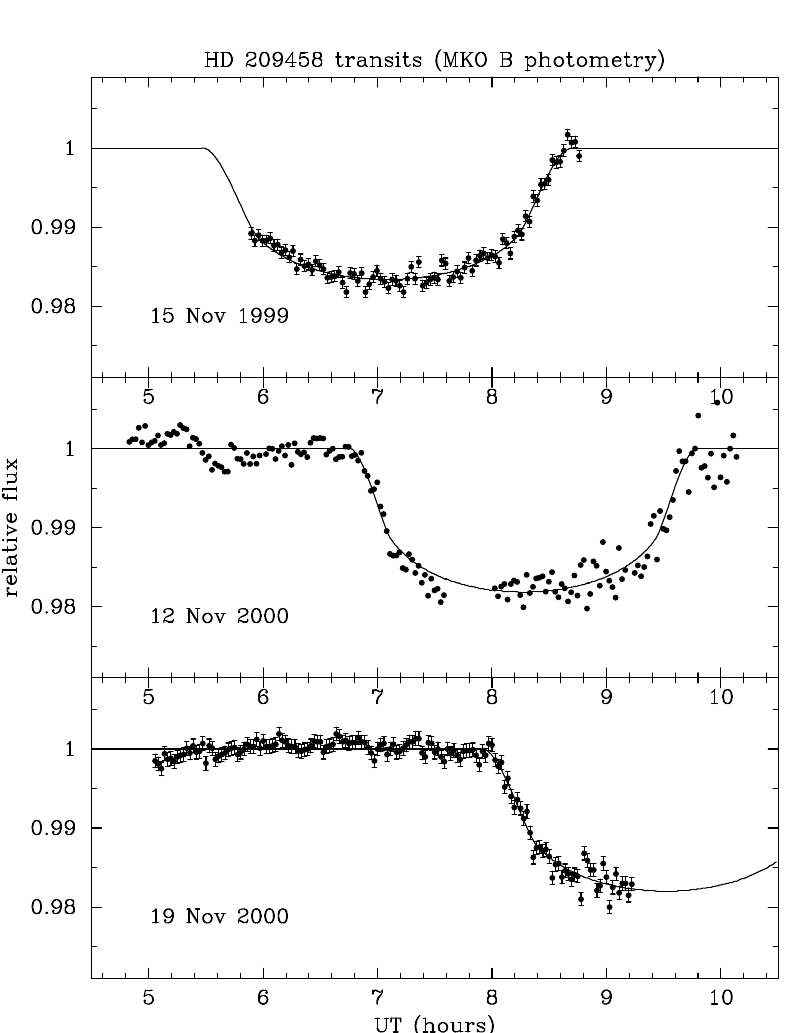
Fig. 12. The transit observations obtained on three separate nights at Mauna Kea Observatory and the relevant limb darkening model fits. The data uncertainties in the top and bottom panels were obtained by examining the quality of the photometry on the night in question, but this was not attempted for the middle panel data due to the cloud